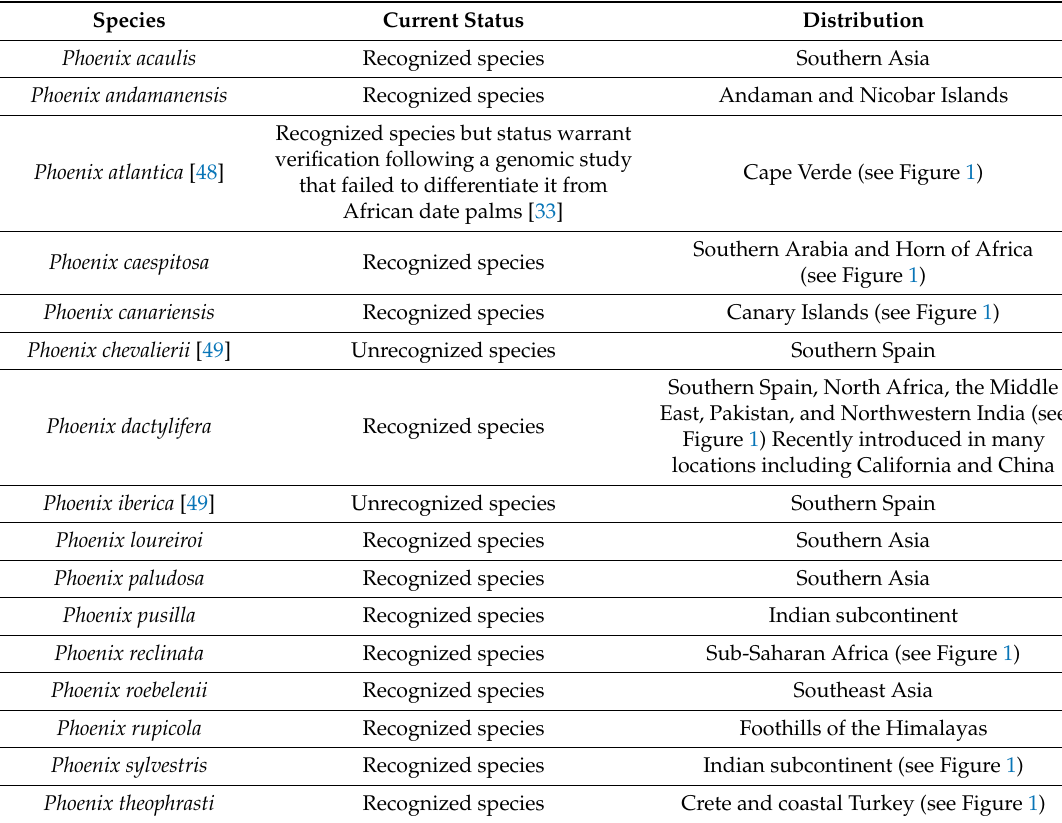
Table 3. List of Phoenix species based on the latest monograph of the genus [5]. Detailed information on their status, morphology, uses, and distribution may be found in a previous paper [5] and on Palmweb [47]. Additional references are indicated for species described after the publication of the monograph or when further information was recently